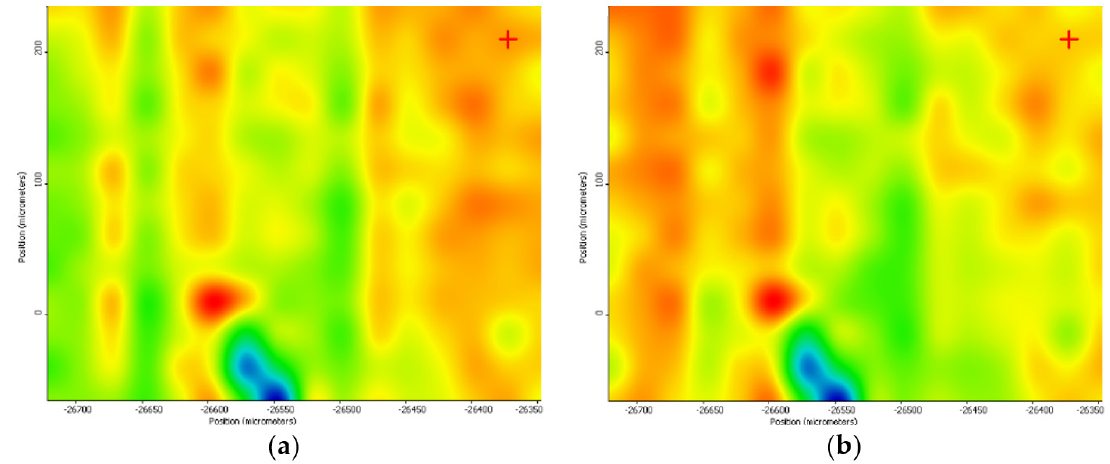
Figure 12. IR maps of PVP/ZnO@LiN based on the distribution of C–H ( a ) and C=O ( b ) bonds at 300 mJ/cm 2 laser fluence. The MAPLE deposition at 400 mJ/cm 2 laser fluence resulted in the degradation of functional groups in the structure of the sample due to the high energy applied (Figure 13). By analyzing the IR maps of these three experimental variants, it can be concluded that the most uniform chemical distribution and the lowest degree of functional group degra- dation were recorded in the case of 300 mJ/cm 2 laser fluence. Therefore, the 300 mJ/cm 2 laser fluence was selected as the optimal choice for MAPLE deposition of PVP/ZnO@LiN coatings regarding the compositional integrity and transfer efficiency. Considering the above discussed IR data, all coatings considered for further analyses were obtained using 300 mJ/cm 2 laser fluence during MAPLE